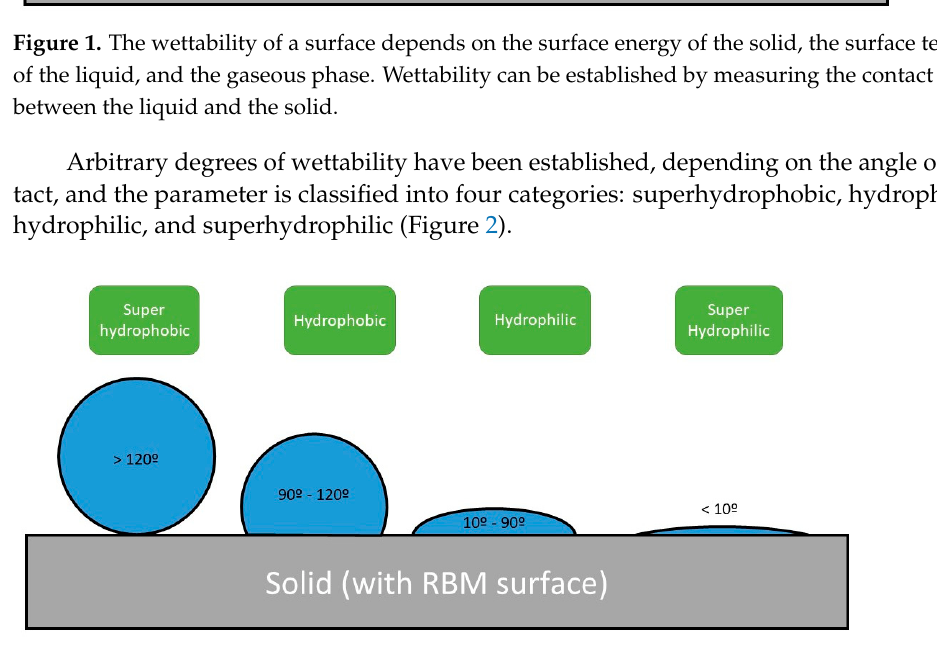
Figure 2. Classification of wettability as a function of contact angle. From superhydrophilic to su- perhydrophobic.